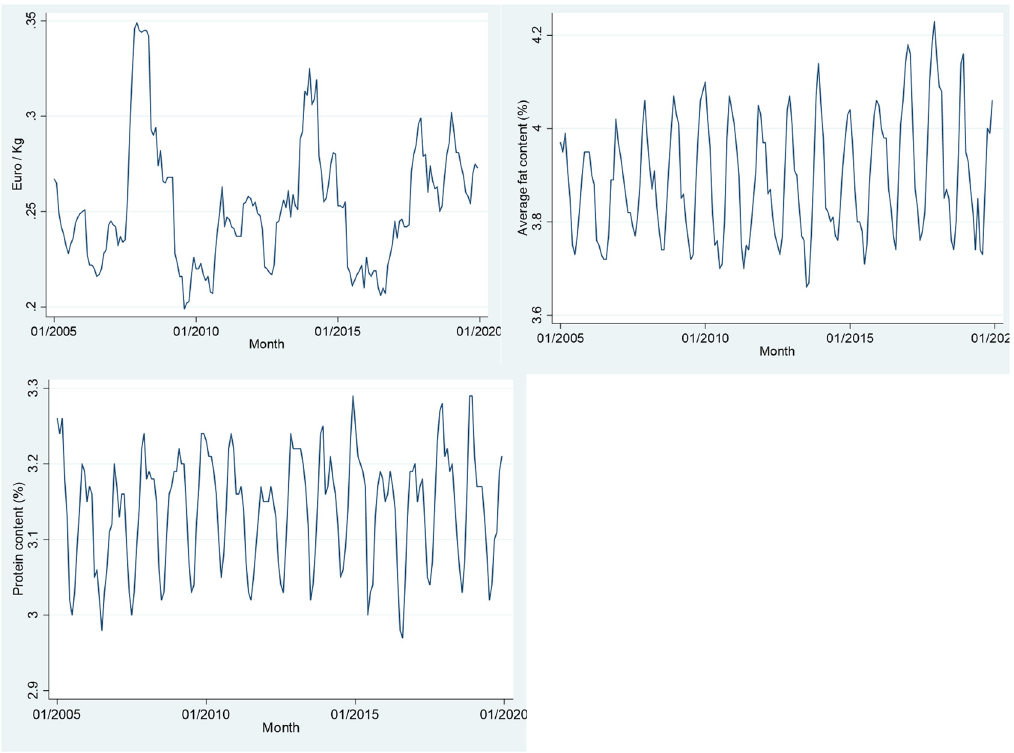
Figure 2: Average monthly prices and characteristics ( 2005 – 2019 ) in Portugal Mainland for milk purchased from reception stations and collective milking rooms.